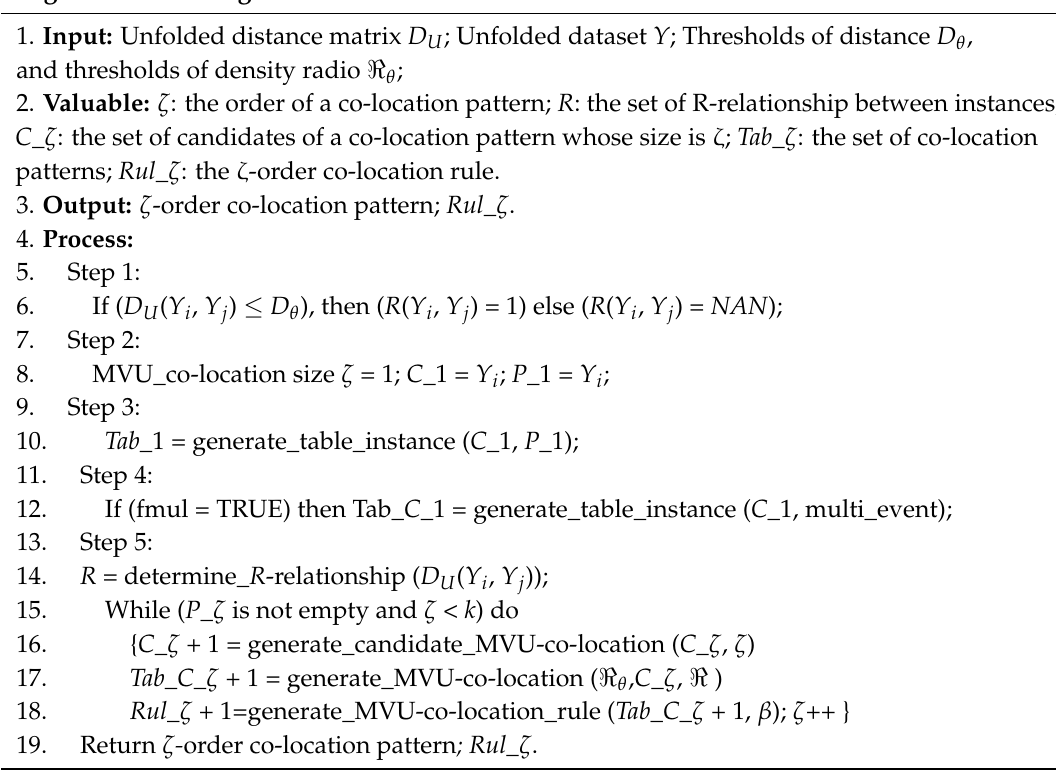
Algorithm 2. the Algorithm of the determination of